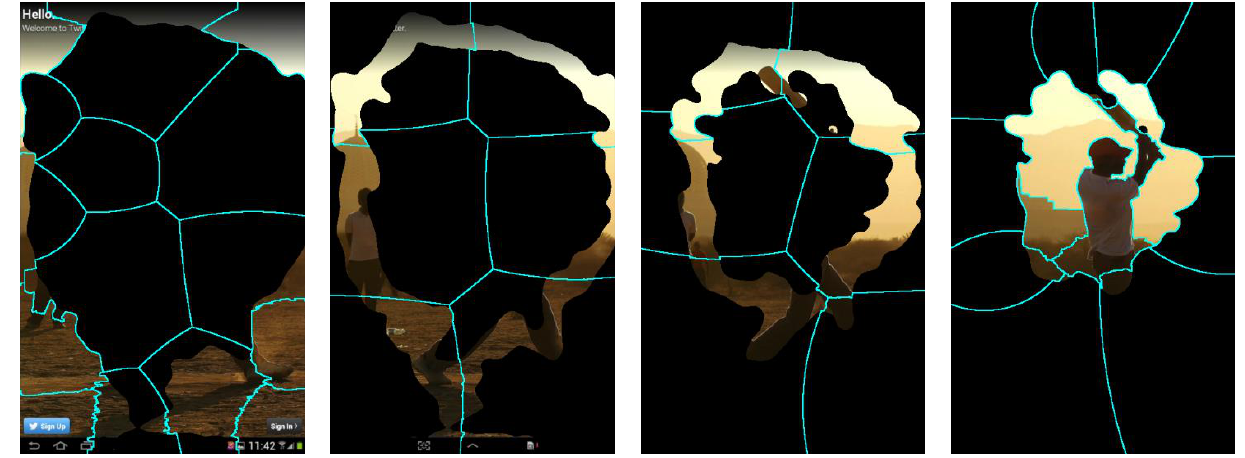
Figure 8. Superpixels of CovSal clusters.